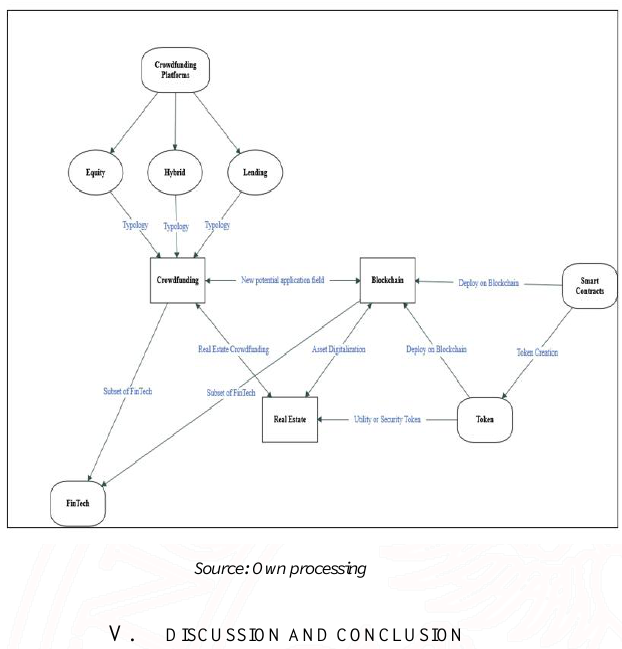
Figure 7 - Practical-conceptual